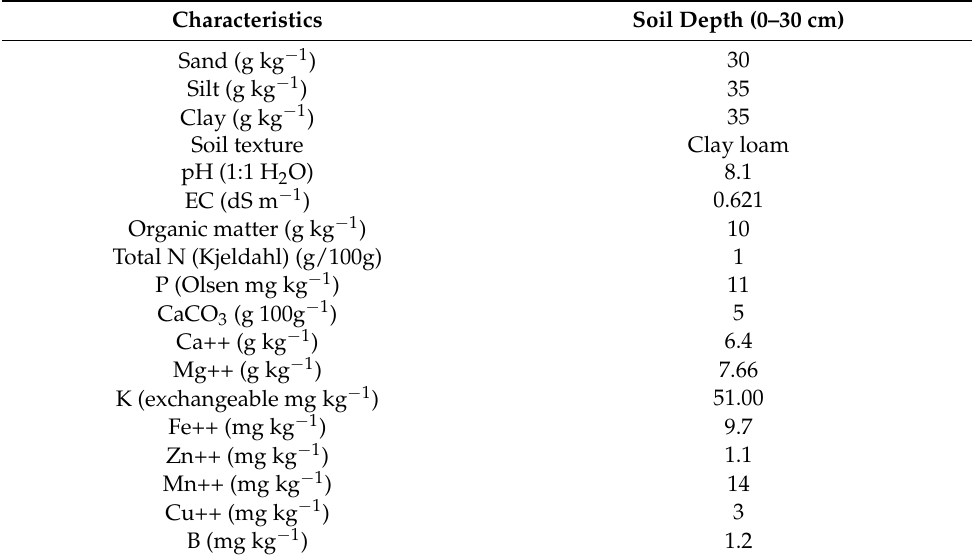
Table 1. Soil characteristics of the experimental field at the University Farm where the experiments were